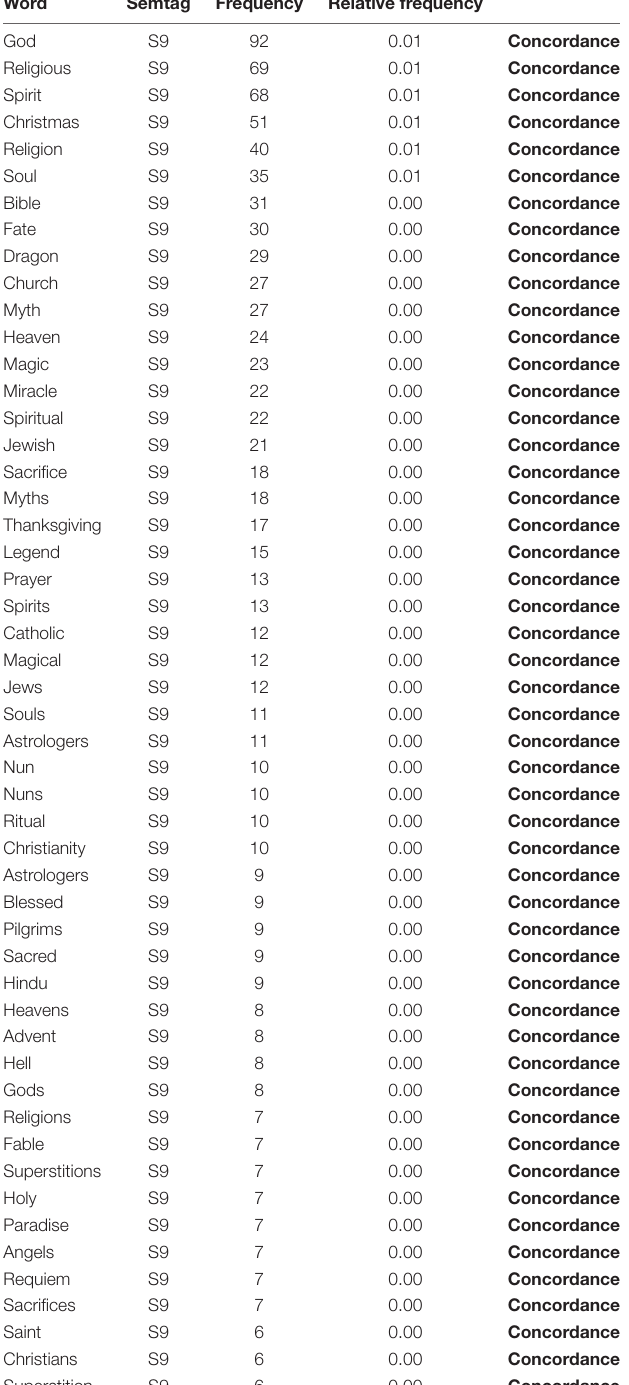
TABLE 3 | The constituents of Religion and the Supernatural . Word